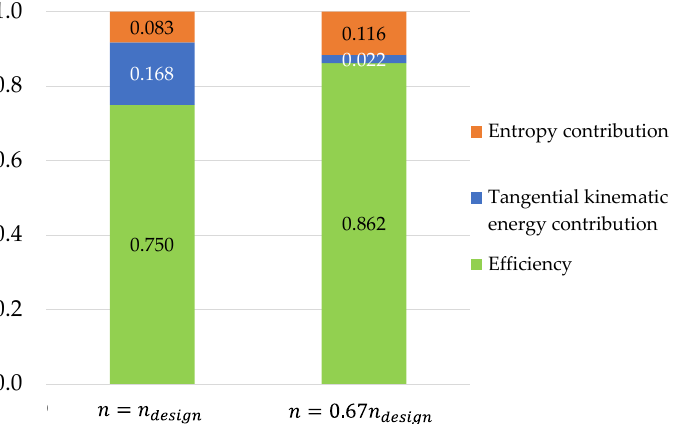
Figure 19. Comparison of main loss contributions and efficiency at 𝑄 = 0.67𝑄 (cid:3031)(cid:3032)(cid:3046)(cid:3036)(cid:3034)(cid:3041) for two differ- ent rotational speeds— 𝐻 (cid:3041) = 𝑐𝑜𝑛𝑠𝑡 .